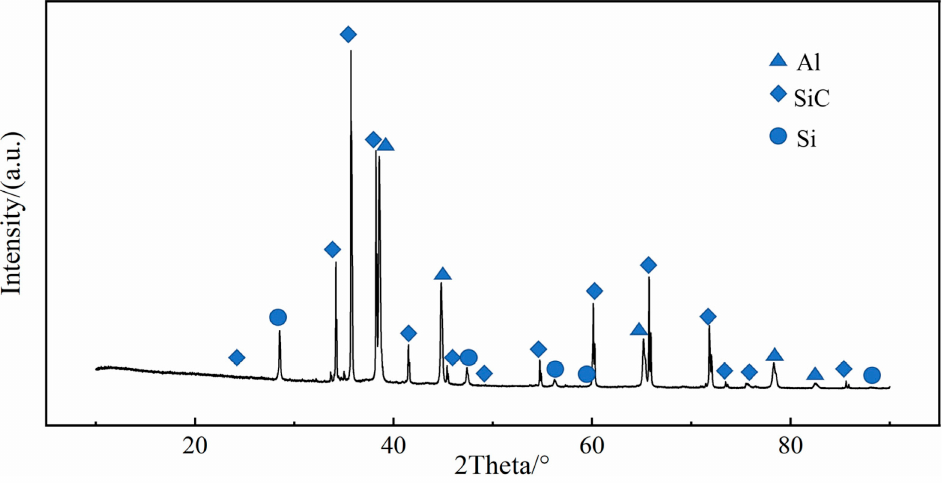
Figure 10. XRD analysis of SiC/Al-12Si-Mg.